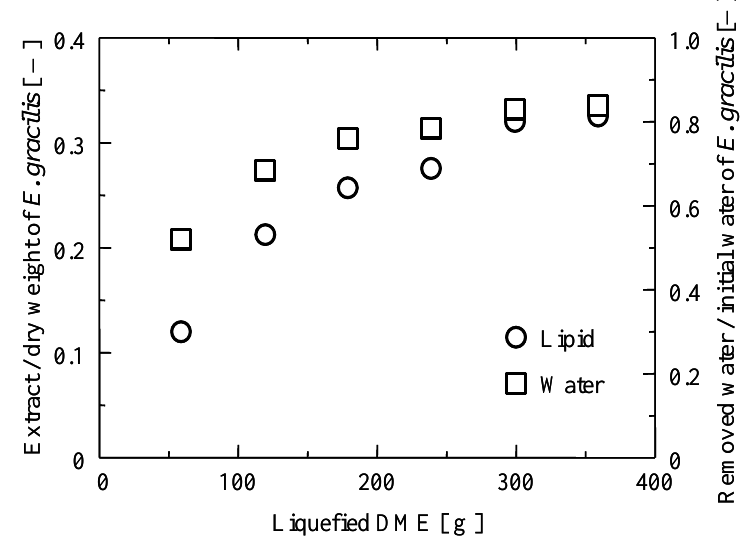
Figure 1. Extraction yields from wet E. gracilis with liquefied